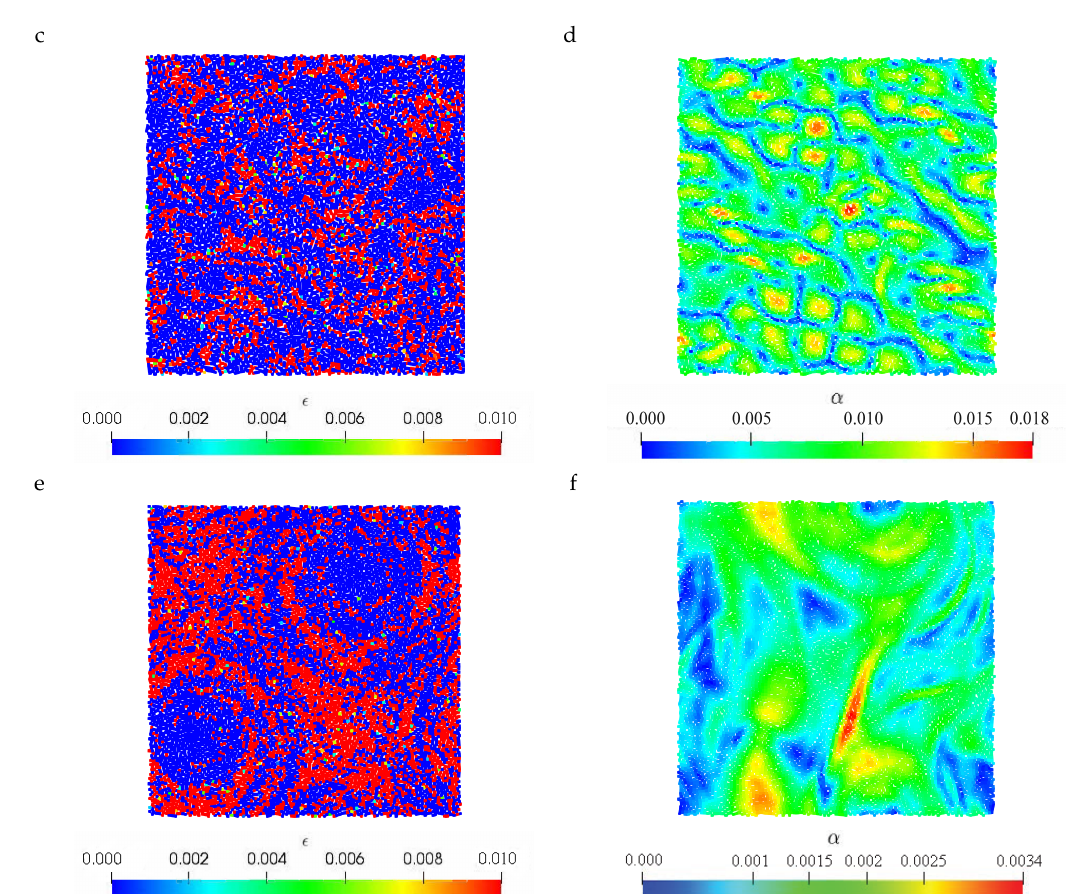
Figure 8. Inviscid two-dimensional Taylor–Green flow. Results for (cid:101) and α fields. On the left, the results obtained using the δ + -ADA-SPH for t = 0.5 ( a ), t = 2 ( c ) and t = 20 ( e ). On the right, the results obtained using the δ + -LES-SPH [16] approach for t = 0.5 ( b ), t = 2 ( d ) and t = 20 ( f ). Results computed using a resolution of 10,000